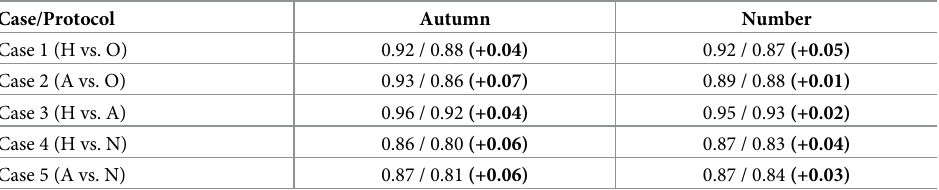
Table 3. Macro-average AUCs for the proposed PWSI-AI and baseline